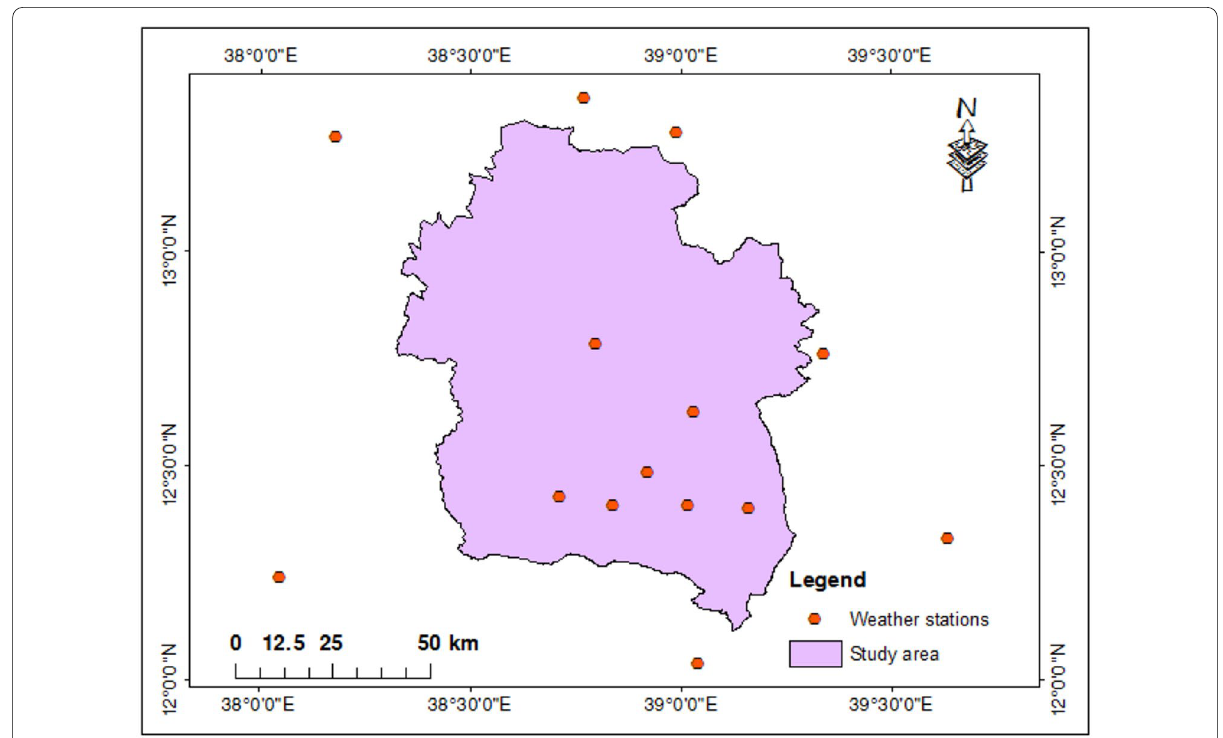
Fig. 2 Location of weather station in Waghimra Zone